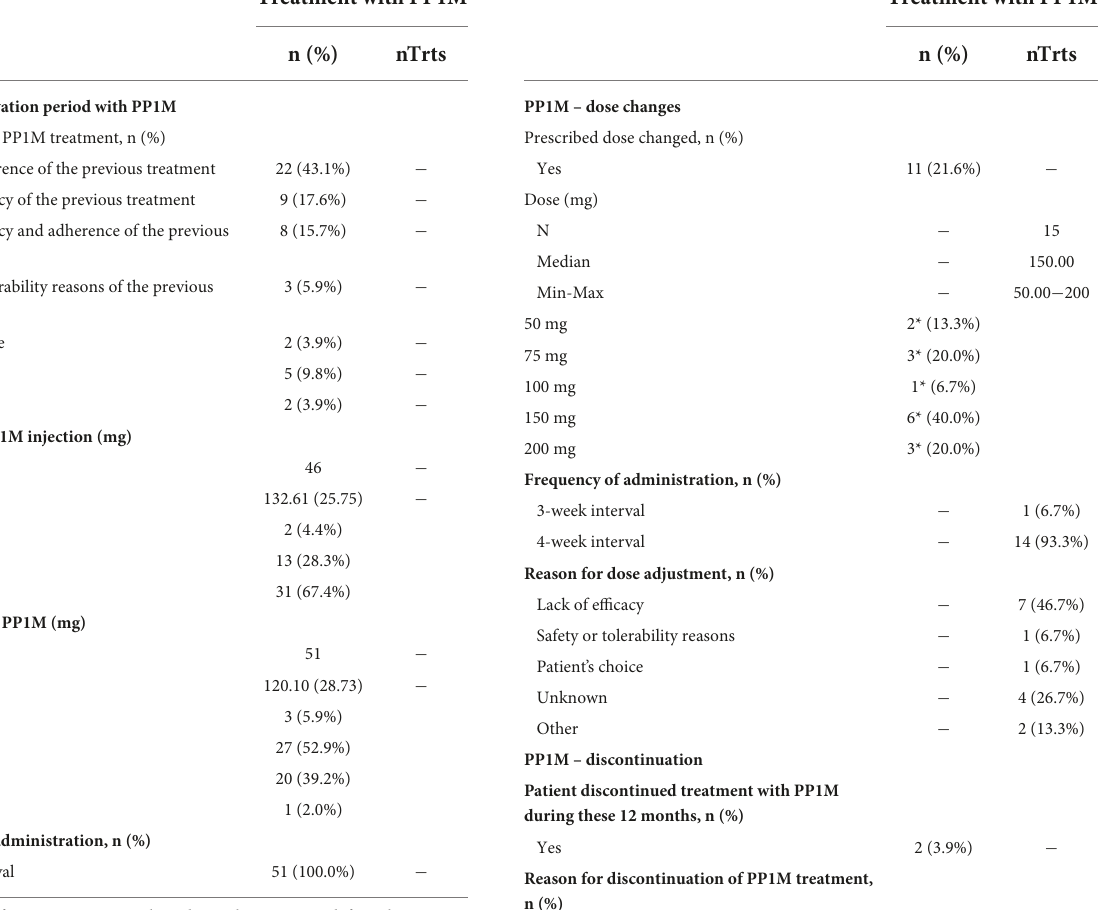
TABLE 3 Treatment with palmitate 1-month formulation (PP1M) at the start of the observation period.